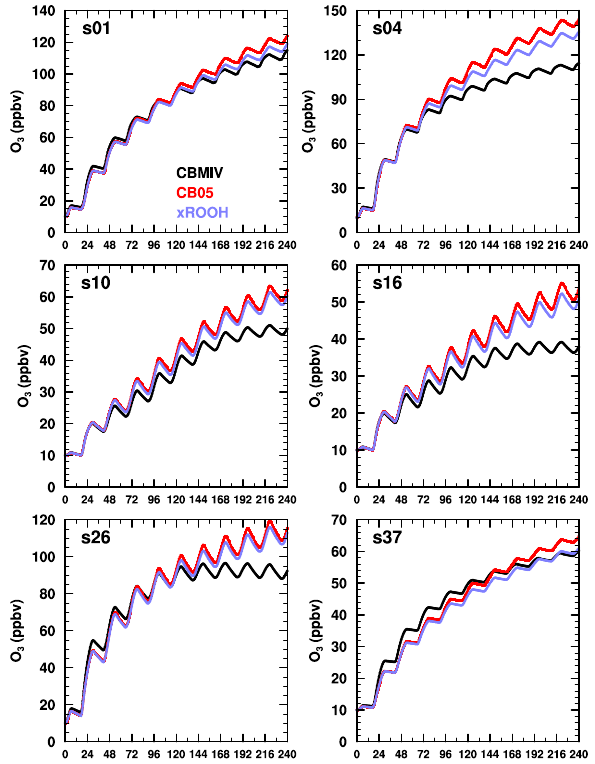
Fig. 8. Example scenario results for sensitivity test xiNOxrecycle. Figure 8 . Example scenario results for sensitivity test xiNOxrecycle . Ozone mixing ratios 3 Ozone mixing ratios (ppbv) for the base CB05 (red), base CBMIV (ppbv) for the base CB05 (red), base CBMIV (black) and sensitivity test xiNOxrecycle (violet) 4 over the 240 hr simulation period. 5 (black) and sensitivity test xiNOxrecycle (violet) over the 240h 6 simulation